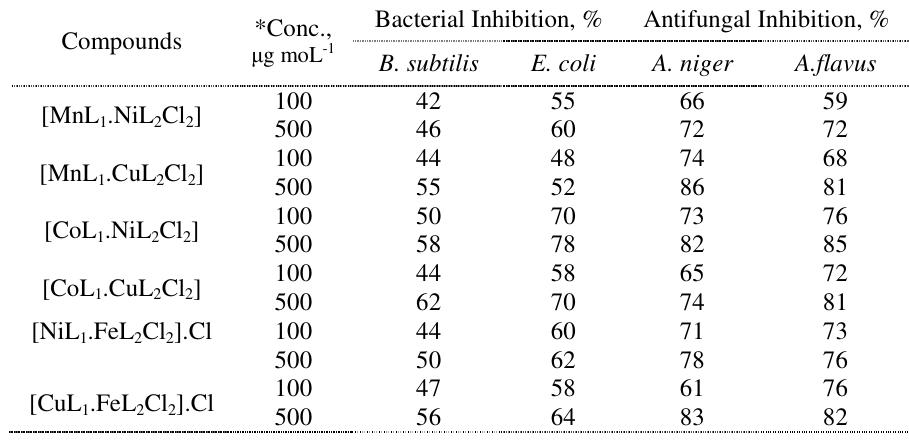
Table 4. Antibacterial and antifungal activity of heterobinuclear metal complexes Bacterial Inhibition, % Antifungal Inhibition, % Compounds